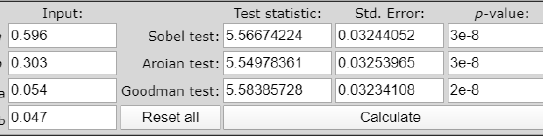
Fig. 5. The Result of Sobel